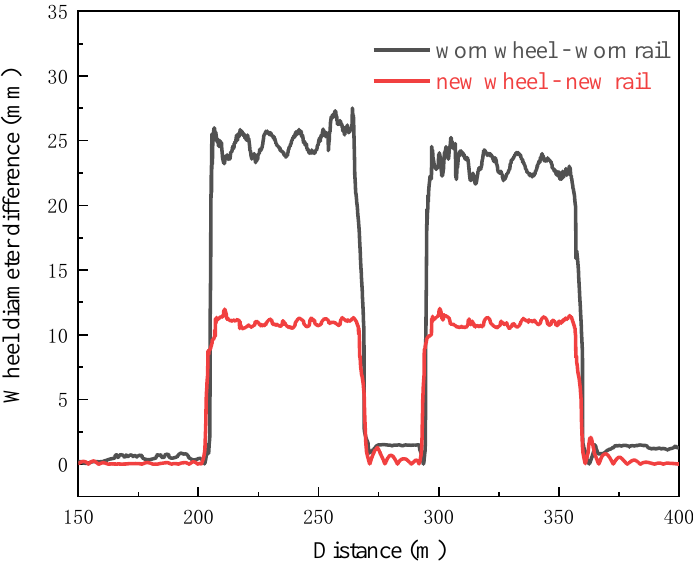
Figure 19. Wheel diameter difference.